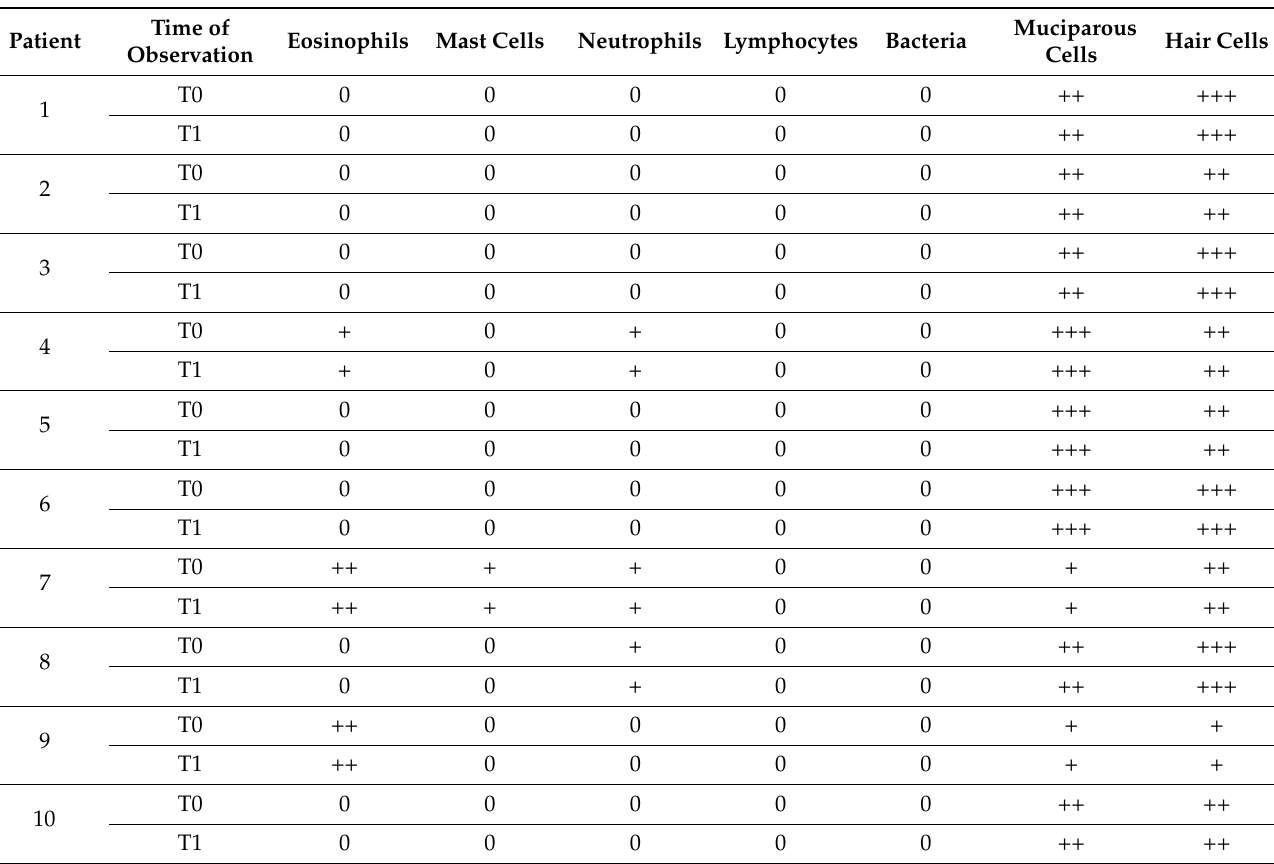
Table 1. Cytological features of volunteers at T0 and at T1.